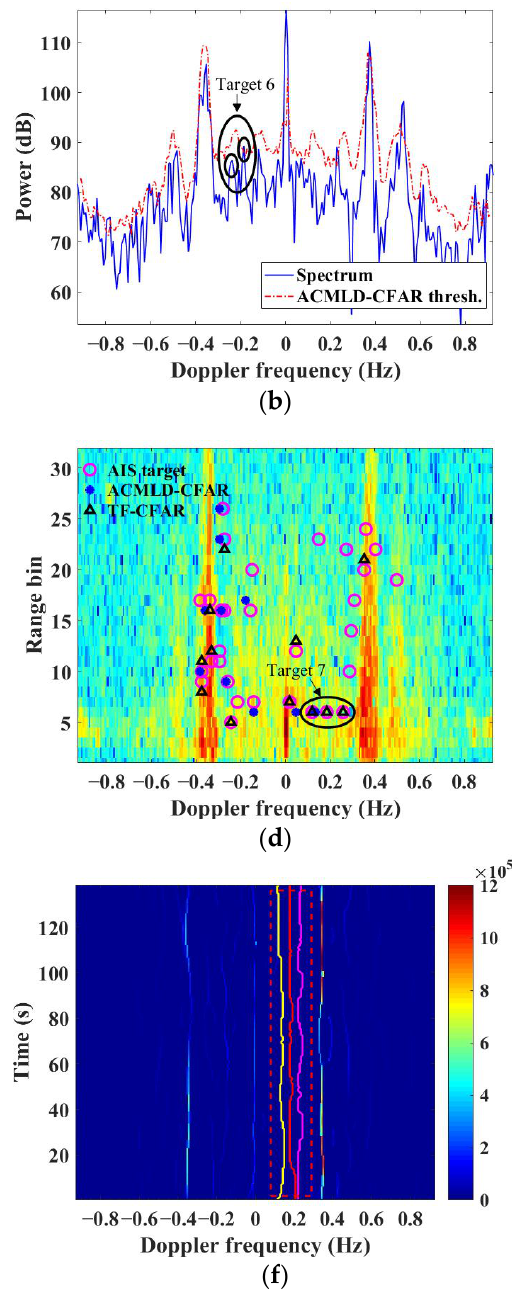
Figure 11. Multi-target detection by ACMLD-CFAR and TF-CFAR at 04:02 and 02:32 on 5 October 2015 and ( b , c , e , f ) are from ACMLD-CFAR and TF-CFAR, respectively. ( a ) target matching map on RD; ( b ) power spectrum at the 5th range bin; ( c ) TF image at the 5th range bin; ( d ) target matching map on RD; ( e ) power spectrum at the 6th range bin; ( f ) TF image at the 6th range bin.